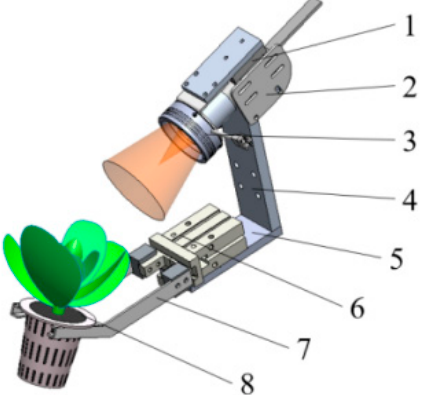
Figure 13. Single-claw transplanting actuator: 1. Camera. 2. Fixing plate. 3. Light source. 4. Connecting plate. 5. Cylinder fixing plate. 6. Pneumatic finger. 7. Gripper. 8. Transplanting cup.